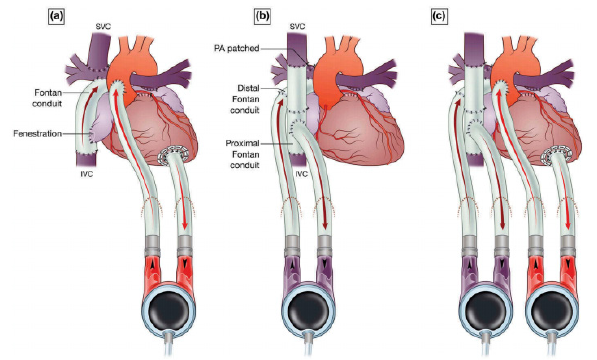
Fig. 2 - Berlin Heart EXCOR® configurations. A) Supports systemic circulation; B) supports pulmonary circulation; and C) supports